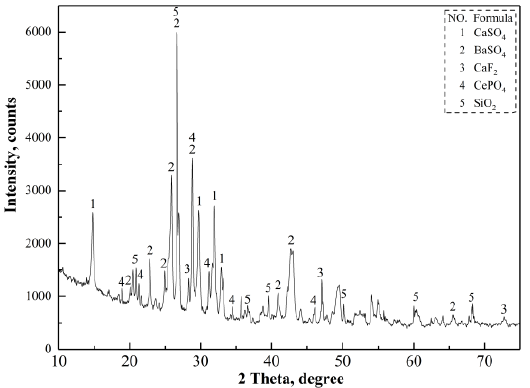
Table 7. Chemical composition of the leaching residues (wt. %).